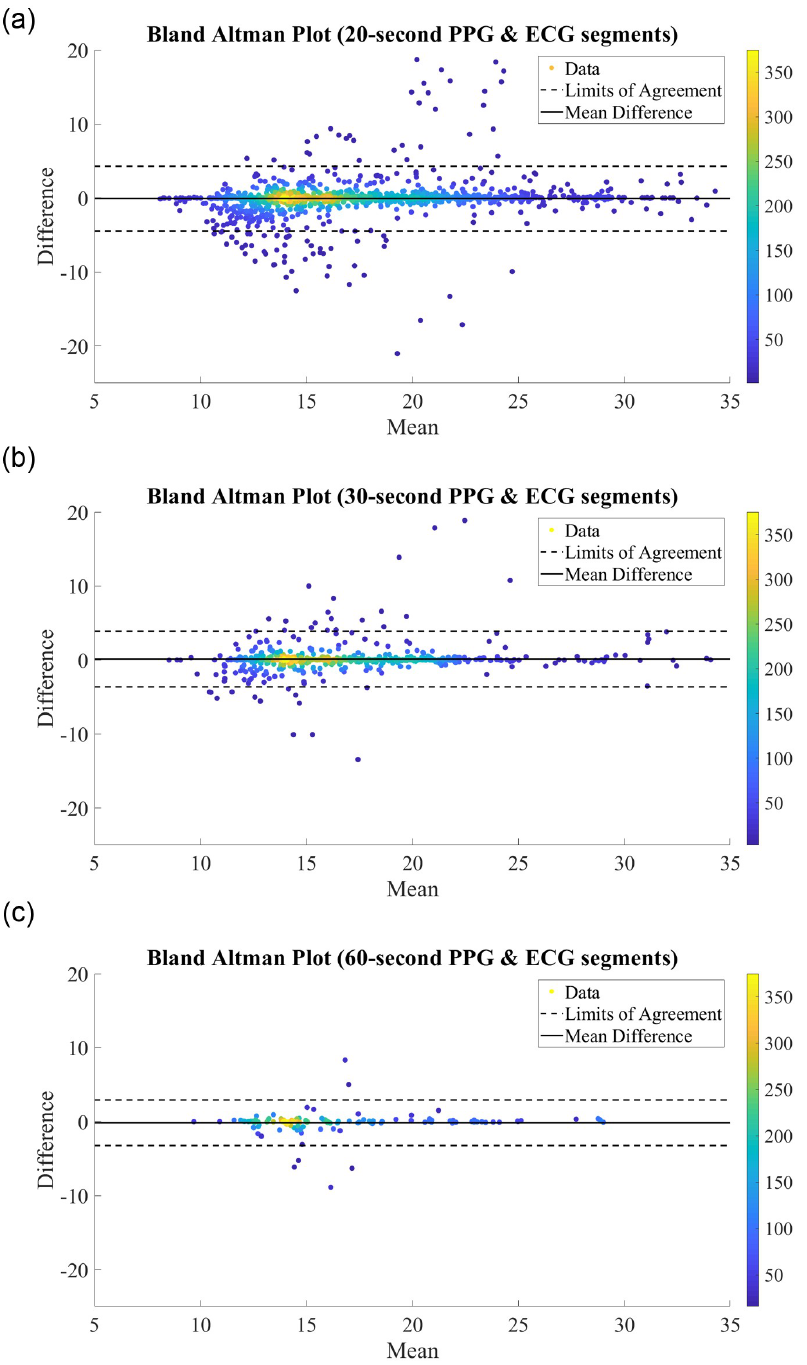
Fig 4. Bland Altman Plots for RR Estimation using RR & RQI features derived from (A) 20-second PPG & ECG segments. (B) 30-second PPG & ECG segments. (C) 60-second PPG & ECG segments.